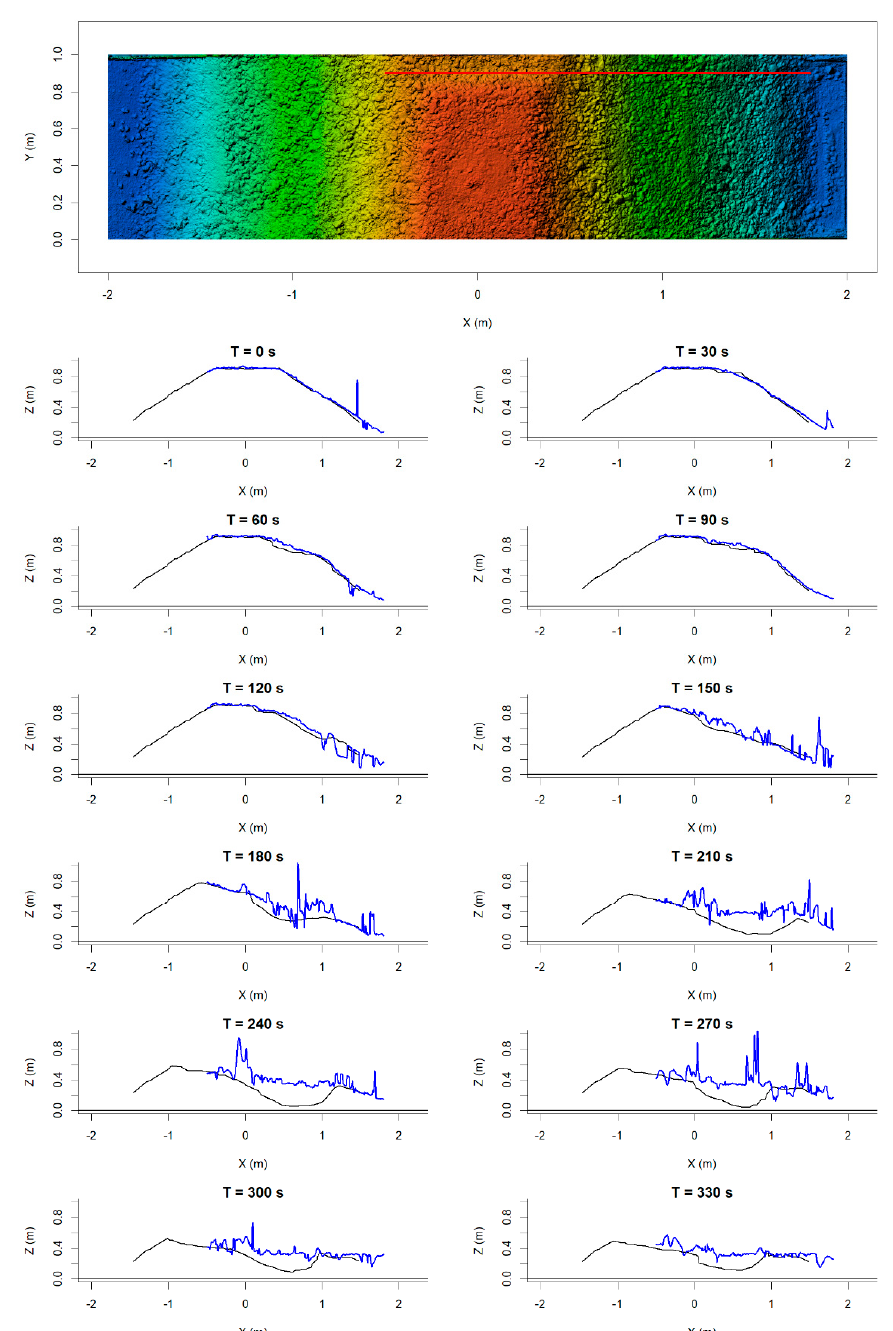
Figure 13. Longitudinal profiles of test U4 from low-resolution dynamic DEM at Y = 0.9 m (blue) and side-view tracking (black) throughout the breaching process; direction of flow is left to right ; T = 0 s is last frame before initial observed erosion at downstream end of pilot channel.